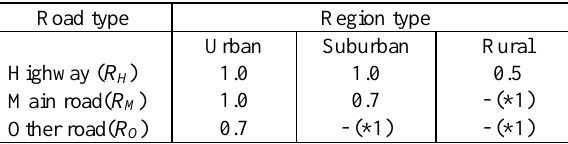
Table 2. Luminance of road in this